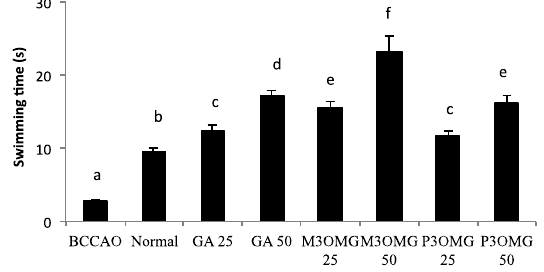
Figure 3. Effects of intraperitoneal administration of GA, M3OMG and P3OMG on climbing time in the despair swimming test. Data are a mean (s) ± SD ( n = 7); different letters indicate statistically significant differences ( p < 0.01) between the two groups.